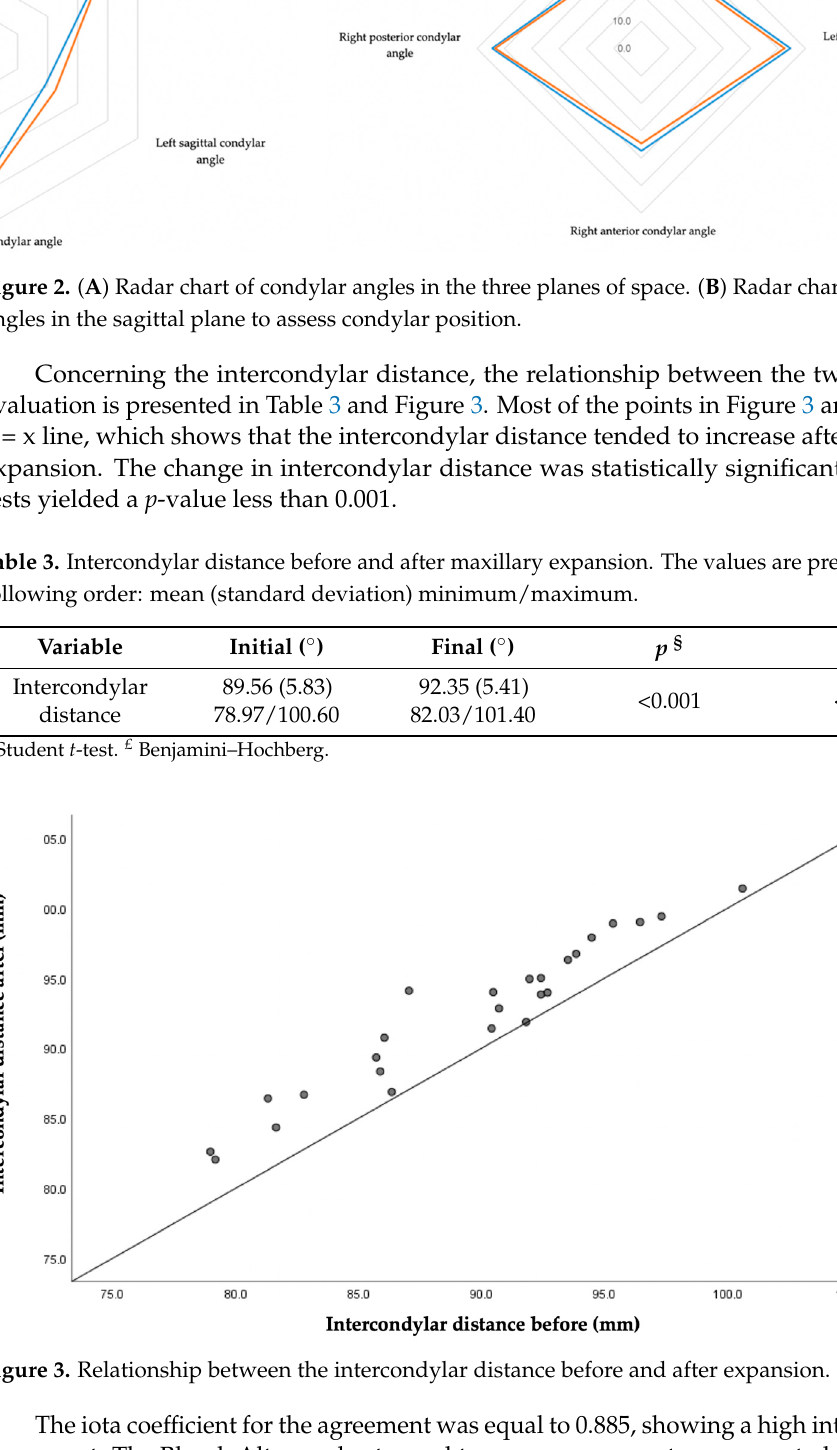
Figure 4. Bland–Altman plots to assess agreement between time points of evaluation. 4. Discussion Knowledge about the position and angulation of the mandibular condyle is crucial for understanding craniofacial development in individuals since the condyles are a growth site and therefore play an important role in mandibular development [25]. Differ ‐ ential condyle growth can be caused by asymmetric masticatory muscle activity due to occlusal problems [26]. The present study aimed to evaluate changes in the position and angulation of the mandibular condyle, as well as the mandibular fossa, in CLP patients after maxillary expansion. It was verified that regardless of the CLP phenotype, the inter ‐ condylar distance tended to increase, and most patients maintained an anterior condylar position in the mandibular fossa after maxillary expansion. Posterior crossbite is often found on the cleft side in patients with CLP. This maloc ‐ clusion can trigger continuous abnormal muscle function that can promote a TMJ remod ‐ eling process. In this study, it was found that the positions of the left and right condyles in the mandibular fossa before treatment did not show specific differences. This finding is in accordance with a study by Leonardi et al. [27], which verified that the position of the condyles in the mandibular fossa were maintained in healthy patients that underwent maxillary expansion. The symmetry between the condylar positions before performing maxillary expansion can be explained by compensatory remodeling of the condyle, which